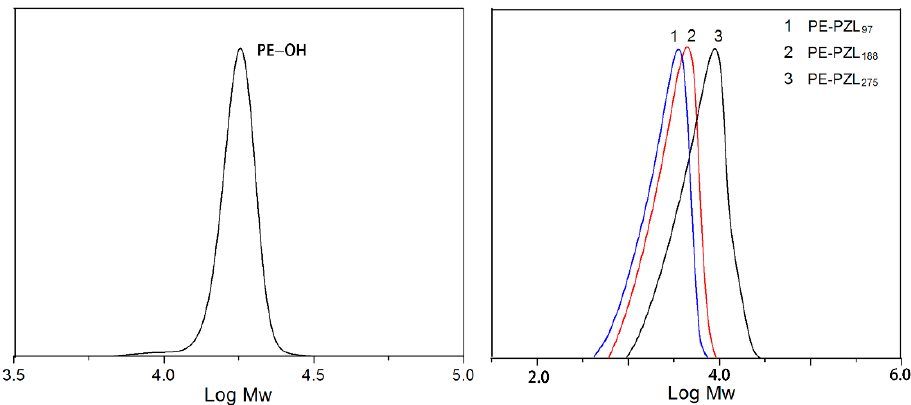
Figure 1. GPC curves of PE–OH ( left ) and PE- b -PZL copolymers ( right ).